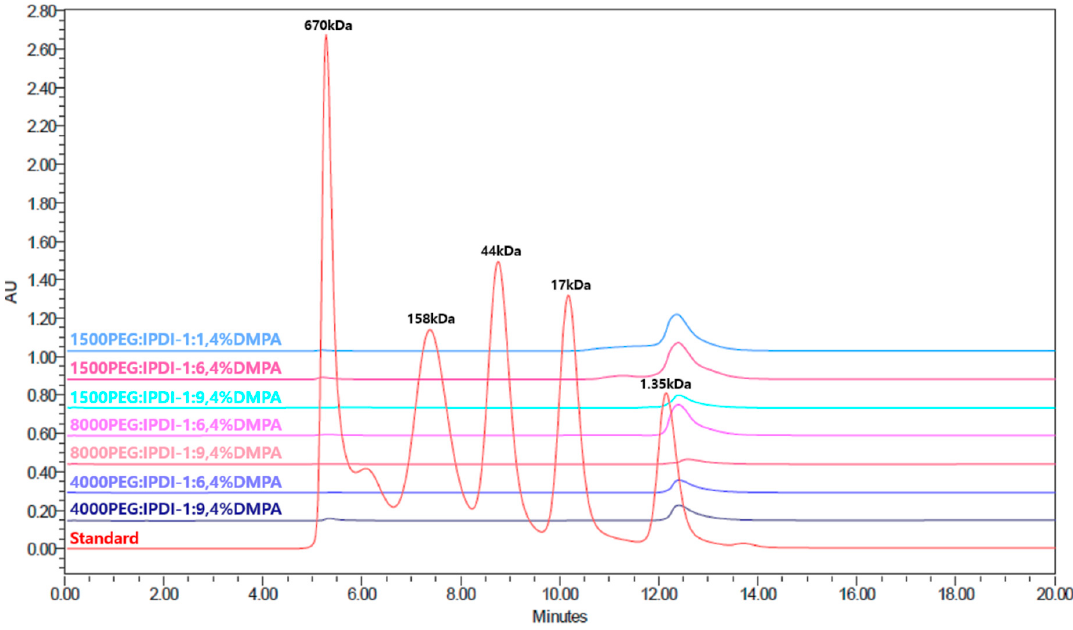
Figure 4. NMR structure of WSPU.